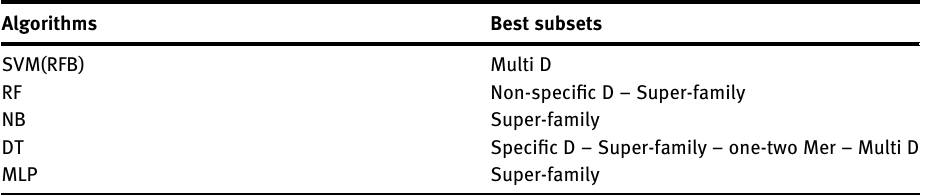
Table  : The selected subsets for each algorithm. Algorithms